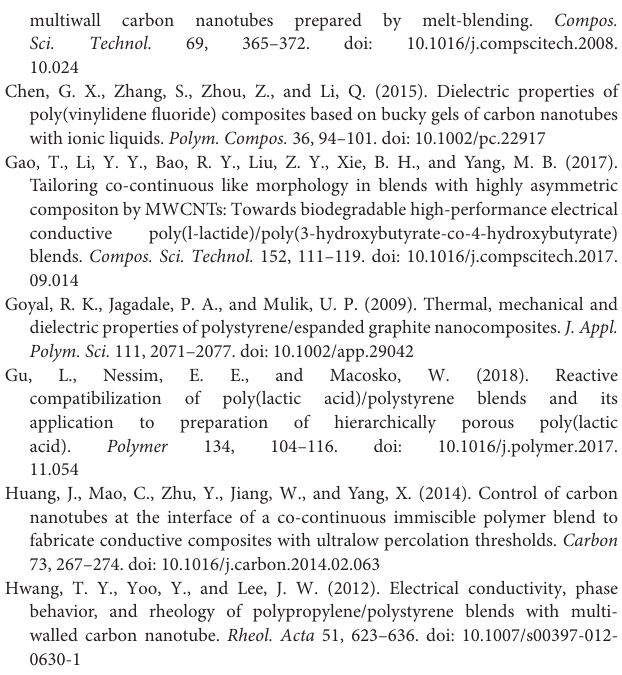
formation of an insulating layer of IL (in higher proportion) that wraps the CNT, thus avoiding the conductive contact. The co-continuous morphology of the blends became thinner with the presence of the filler, due to changes in the viscosity ratio between the blend